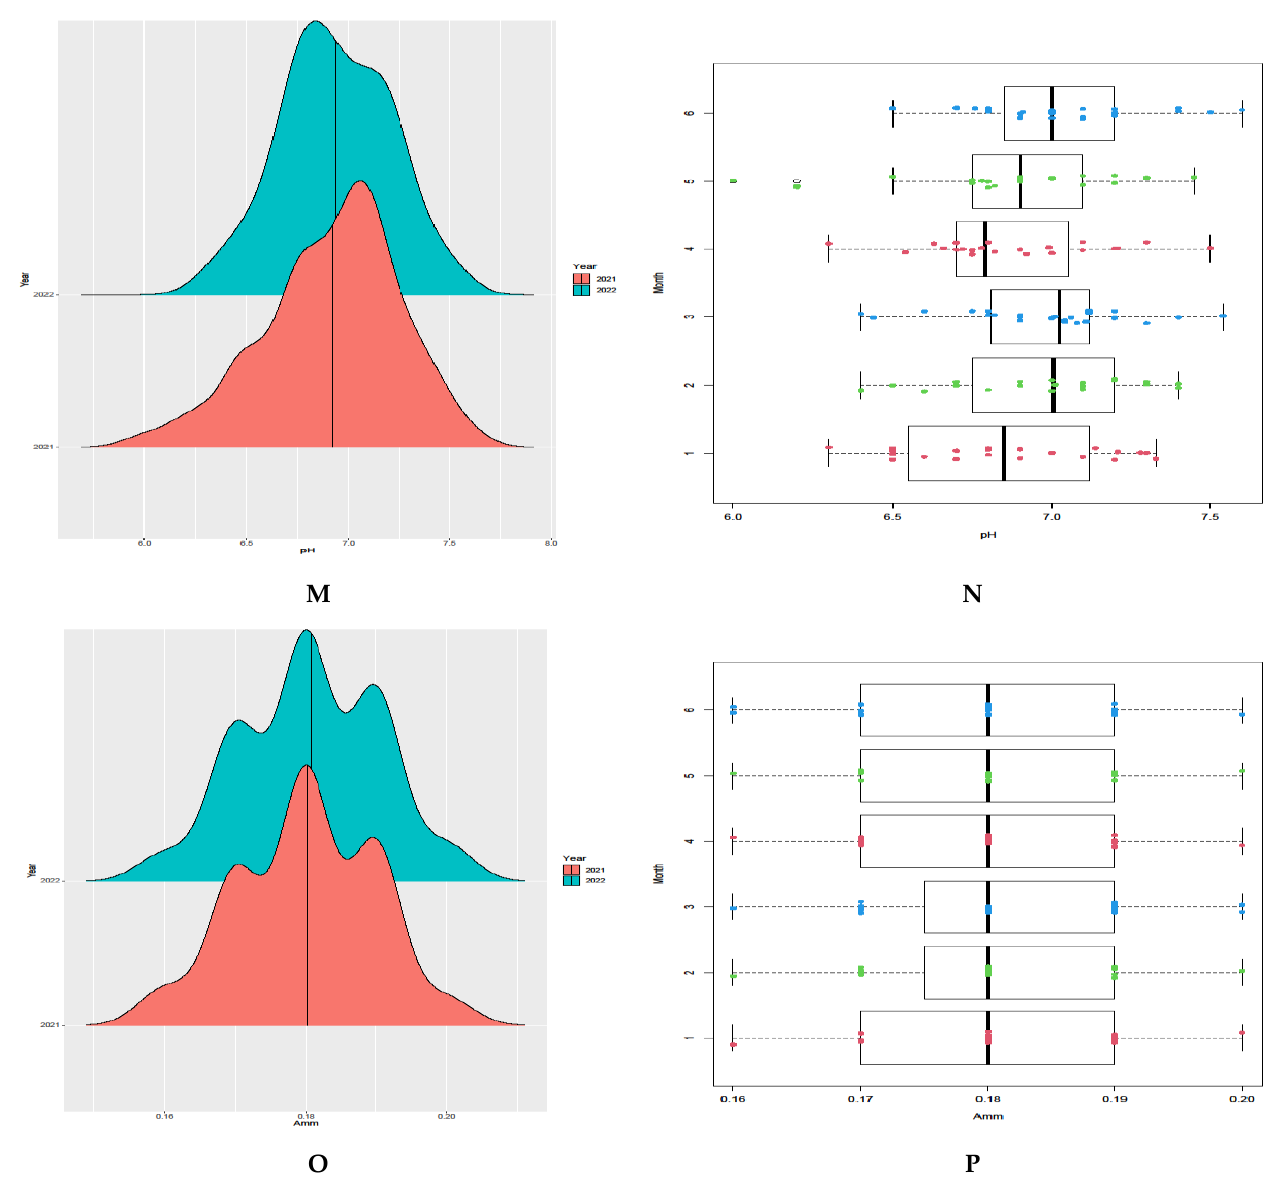
Figure 2. Yearly and monthly water quality variation in the Halda River and Sylhet Haor basin (Surma River and Tanguar Haor) during the spawning period. Temperature = ( A , B ); DO = ( C , D ); TDS = ( E ,F); Salinity = ( G , H ); Turbidity = ( I , J ); Conductivity = ( K , L ); pH = ( M , N ) and Ammonia = ( O , P ). Where figure Left = Year, Right = Month (1, 2, 3, 4, 5, 6) = March, April, May, June, July, August.